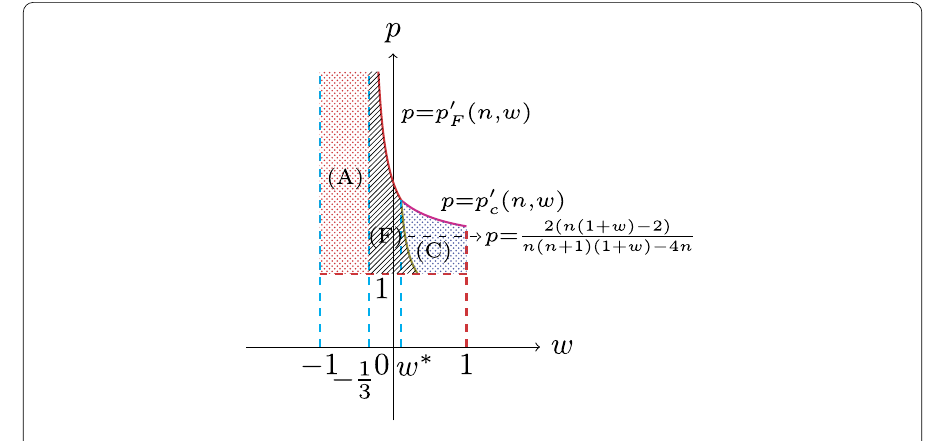
Figure 7 Range of blow-up conditions in case n =